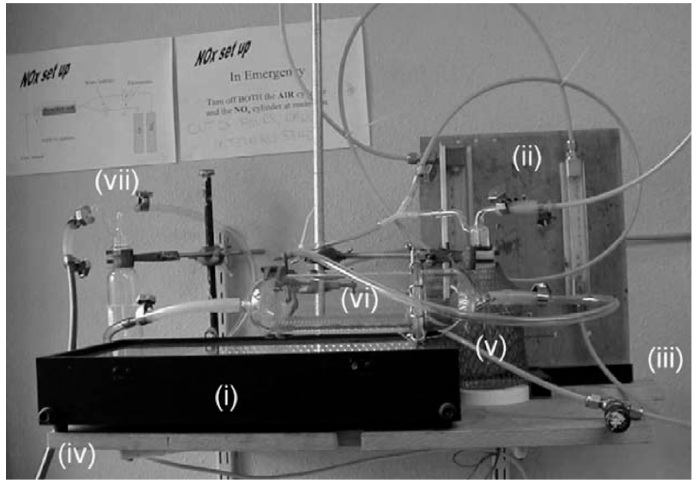
Figure 21. Apparatus for NO x gas removal. Shown are: (i) UV exposure box; (ii) gas flow meters; (iii) NO x gas and air mixer gas in; (iv) gas out; (v) water bubbler for air mixer gas; (vi) glass reaction vessel; and (vii) sodium hydroxide bubbler for excess NO x removal. The system consisted of flow meters to allow an NO x concentration of between 10 and 100 ppm when used in conjunction with the air mixer gas; a water bubbler to allow the reaction to be studied with wet or dry gas’ a second bubbler containing aqueous NaOH was used after the reaction vessel to remove unreacted NO x .